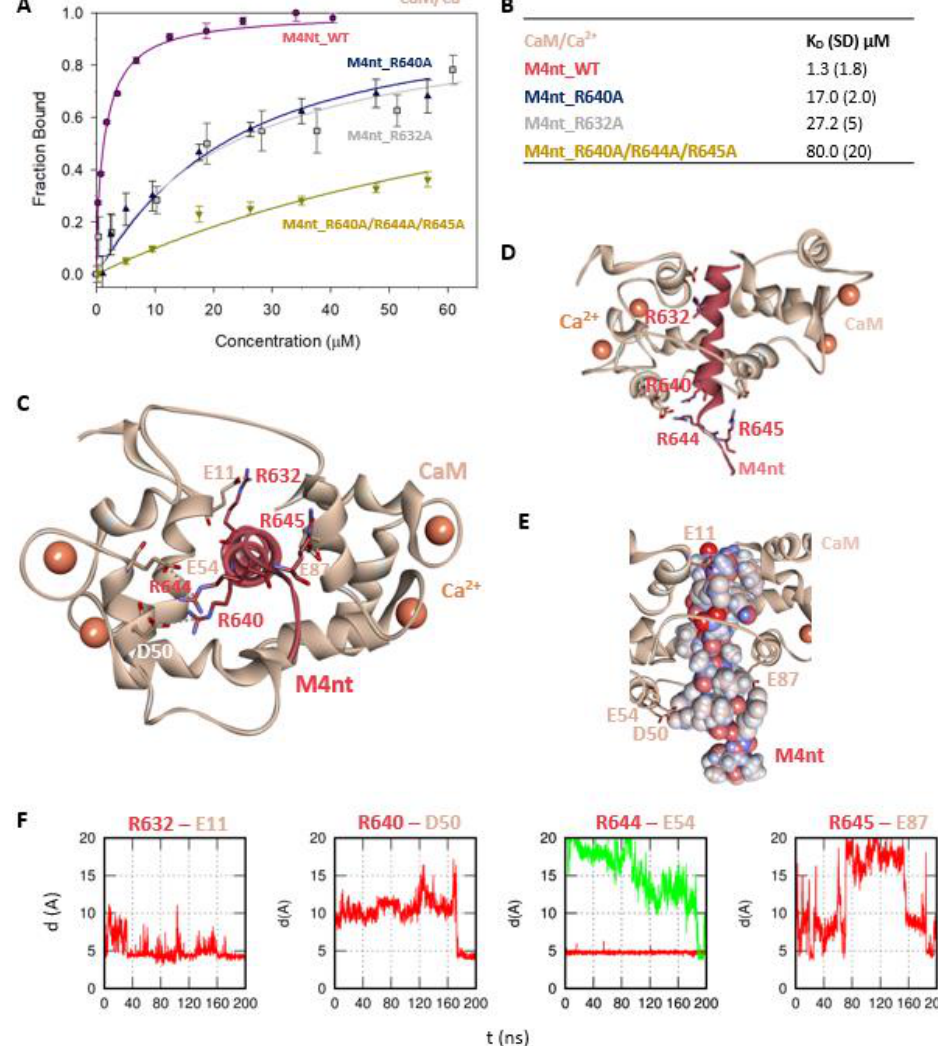
Figure 2. The M4nt / CaM complex. ( A ) The F B of fluorescently labelled M4nt_WT (wild type) (circles), M4nt_R632A (squares), M4nt_R640A (up-triangles) and M4nt_R640A / R644A / R645 (down-triangles) as a function of CaM (beige) concentrations. M4nt peptides were titrated by CaM, and F B was calculated according to Equation (1); the solid lines represent the best fit to the binding isotherm from Equation (2) (Methods). ( B ) The equilibrium K D of the M4nt-binding epitope in complexes with CaM obtained by steady-state fluorescence anisotropy (FA). ( C ) M4nt / CaM in the context of the whole CaM in the presence of Ca 2 + as a result of molecular dynamics (MDs). The side chains of M4nt (ribbon representation, deep-pink colour) amino acids involved in salt bridges with their binding counterparts from CaM (ribbon representation, beige colour) in atomic detail displayed as sticks: R632-E11, R640-D50, R644-E54 and R645-E87. ( D ) The M4nt / CaM complex from the upper view; M4nt and CaM are shown in the same representation as in Figure 2C, with displayed R632, R640, R644 and R645 basic residues (stick representation, deep-pink colour) involved in the interactions with CaM. ( E ) The M4nt / CaM complex from the upper view; M4nt is shown in CPK representation (partial charge colouring), CaM displayed with E11, D50, E54 and E87 negatively charged residues (stick representation, beige colour) involved in the interactions with M4nt. Ca 2 + displayed in a ball representation, orange colour. ( F ) Time-dependent geometry characteristics of the studied salt bridges R632-E11, R640-D50, R644-E54 and R645-E87 from MD simulations. A stable salt bridge is expected to have a distance of about 5Å between the termini of oppositely charged amino acids. K D : equilibrium dissociation constant.